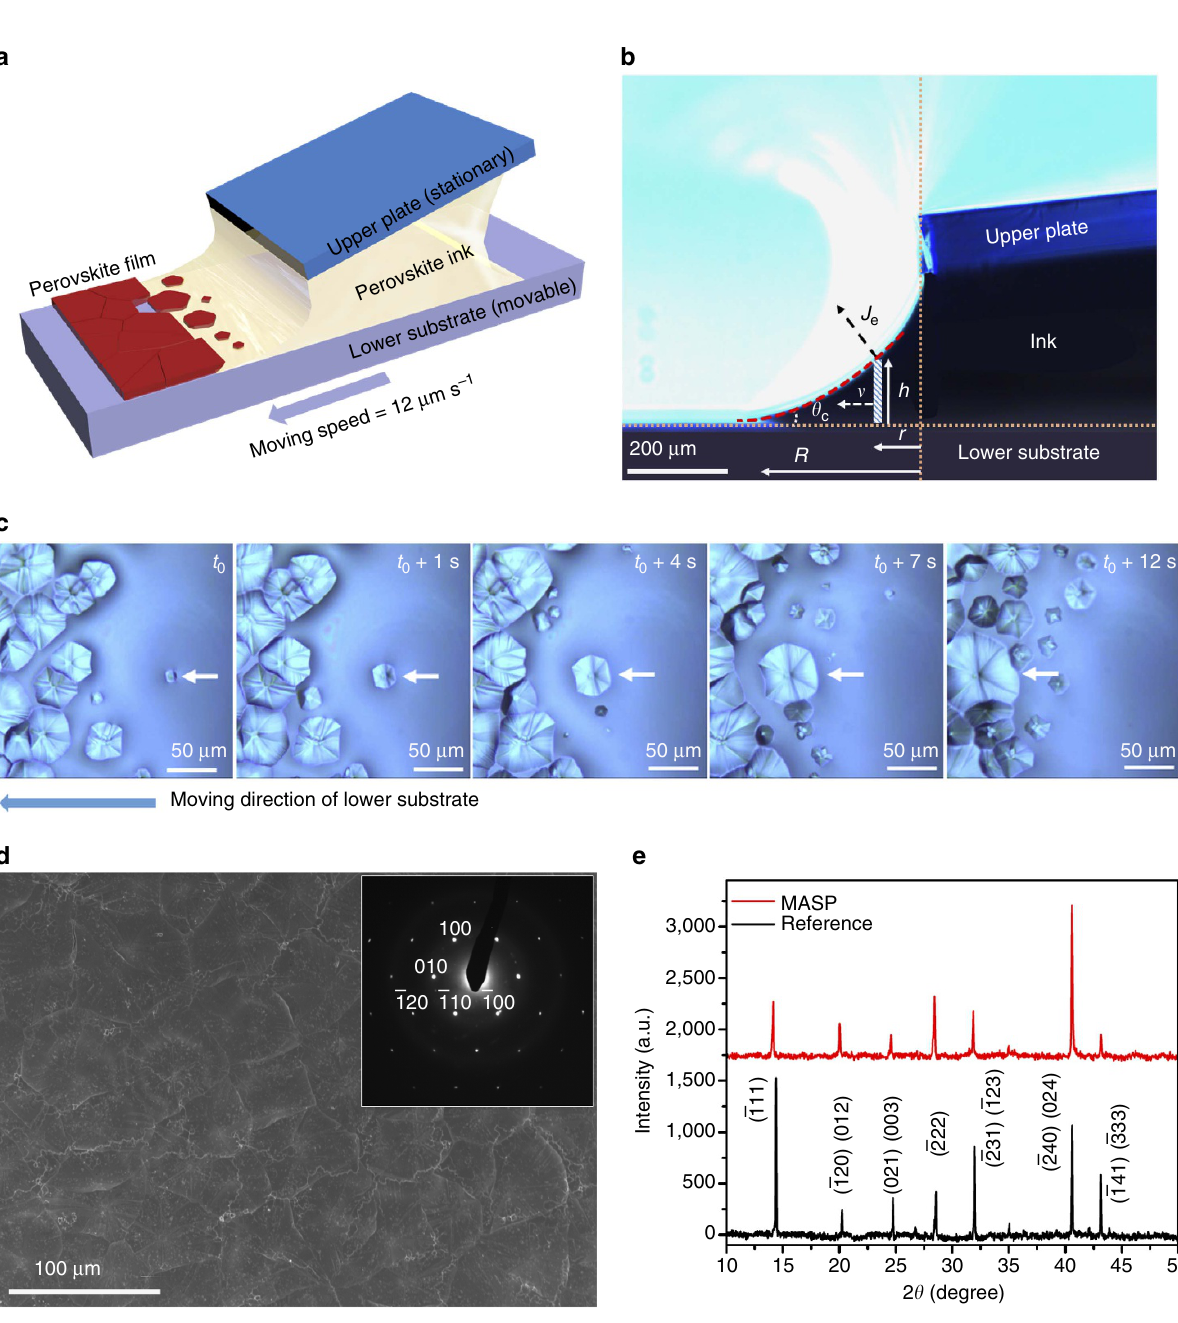
Figure 1 | Meniscus-assisted solution printing of FA 0.85 MA 0.15 PbI 2.55 Br 0.45 perovskite crystal films. ( a ) Schematic illustration of the meniscus-assisted solution printing (MASP) of large-grained perovskite films. ( b ) Optical micrograph of the side-view meniscus ink confined between a lower flat, movable substrate and an upper stationary plate. ( c ) Optical micrograph of the microstructural evolution of FA 0.85 MA 0.15 PbI 2.55 Br 0.45 perovskite grain as a function of time. ( d ) Scanning electron microscopy (SEM) image of the perovskite film crafted by MASP. A representative selected area electron diffraction (SAED) of the perovskite film is shown as an inset. ( e ) X-ray diffraction (XRD) profiles of the perovskite film crafted by MASP (upper) and the reference sample prepared by spin coating